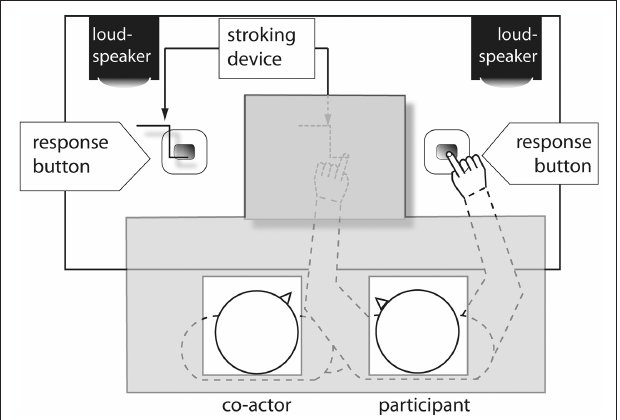
Figure 5 | Mean reaction time as a function of the type of stimulation and spatial stimulus–response compatibility. Error bars represent standard errors of the mean differences. * p < 0.05, ** p < 0.01, n.s.,